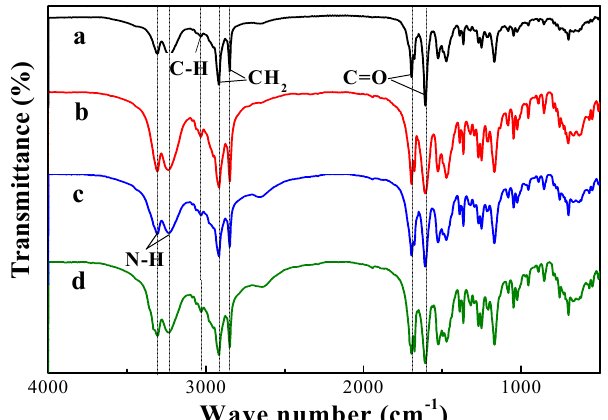
Figure 5. FTIR spectra of compound 4 xerogel in ( a ) benzene, ( b ) n-propanol, ( c ) tetrachloromethane, and ( d ) propyl acetate.